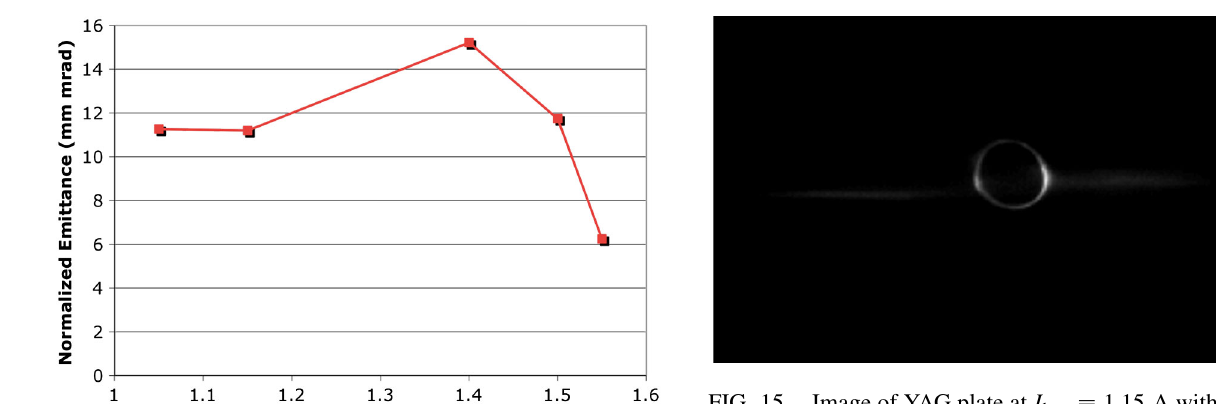
FIG. 15. Image of YAG plate at I Ta slit on the beam axis, showing the circular beam pattern resulting from emission from the central hole in the cathode. The faint horizontal line is produced by the residual electrons emitted from the entire cathode surface and passing through the